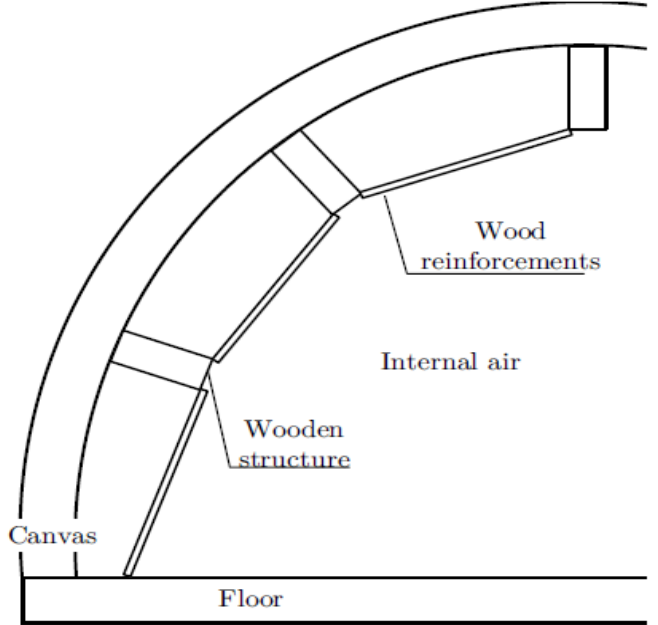
Figure 9. Geodesic dome structure with wood reinforcements.